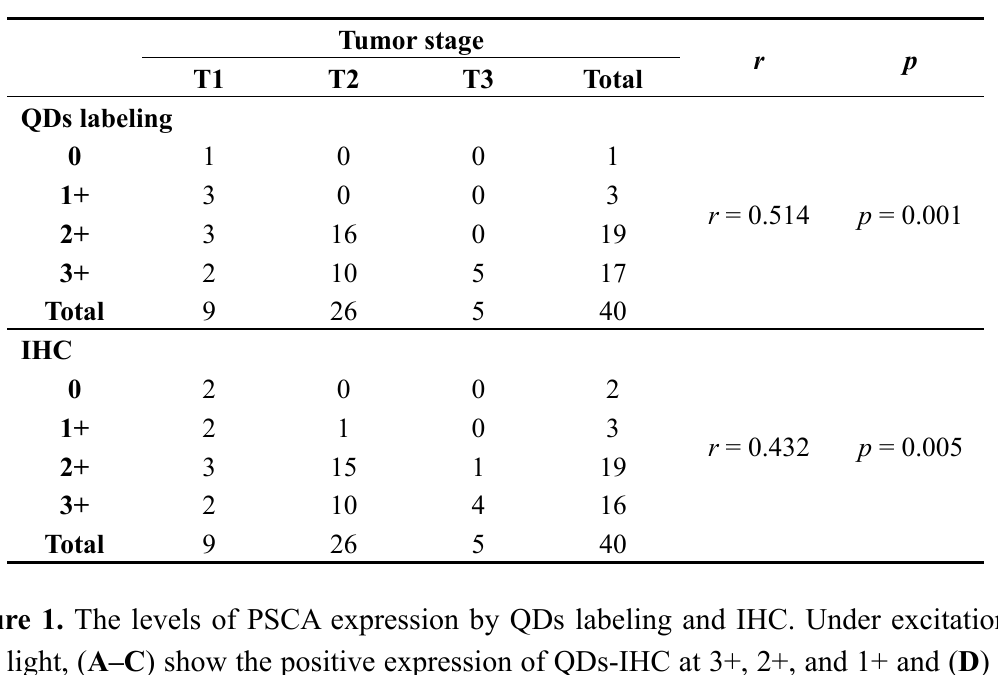
Table 2. Associativity analysis of PSCA expression levels and tumor stage in PCa by two methods.